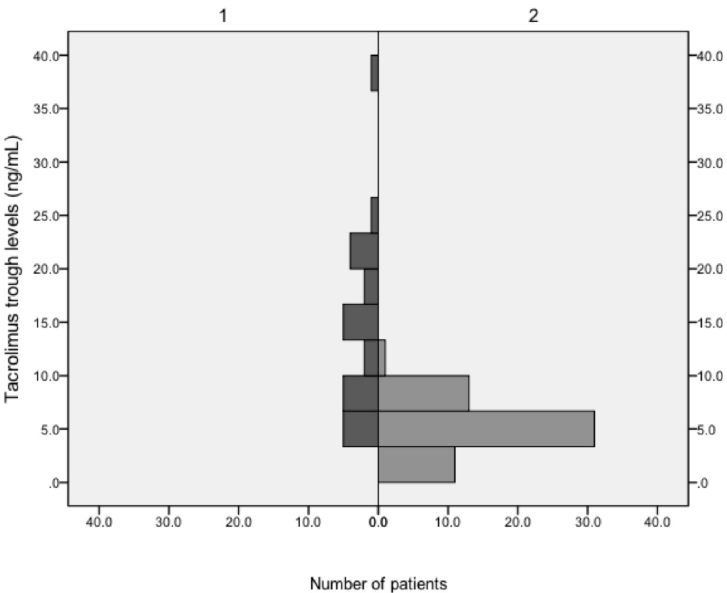
Fig 2. Median tacrolimus trough levels of 87 patients converted from ciclosporin and immediate release tacrolimus to modified release tacrolimus in the first week after conversion (intention to treat population). 1/dark bars = conversion from ciclosporin-based immunosuppression (n = 25; the conversion was performed in 28 individuals, 1 had taken TAC immediately before blood sampling and was excluded from the analysis, 1 failed to appear for the scheduled appointment, and 1 re-converted himself to CSA within the first days of TAC MR4 exposure), 2/light bars = conversion from tacrolimus-based immunosuppression (n = 59). Please note that scale of ordinate and abscissa differs from Fig